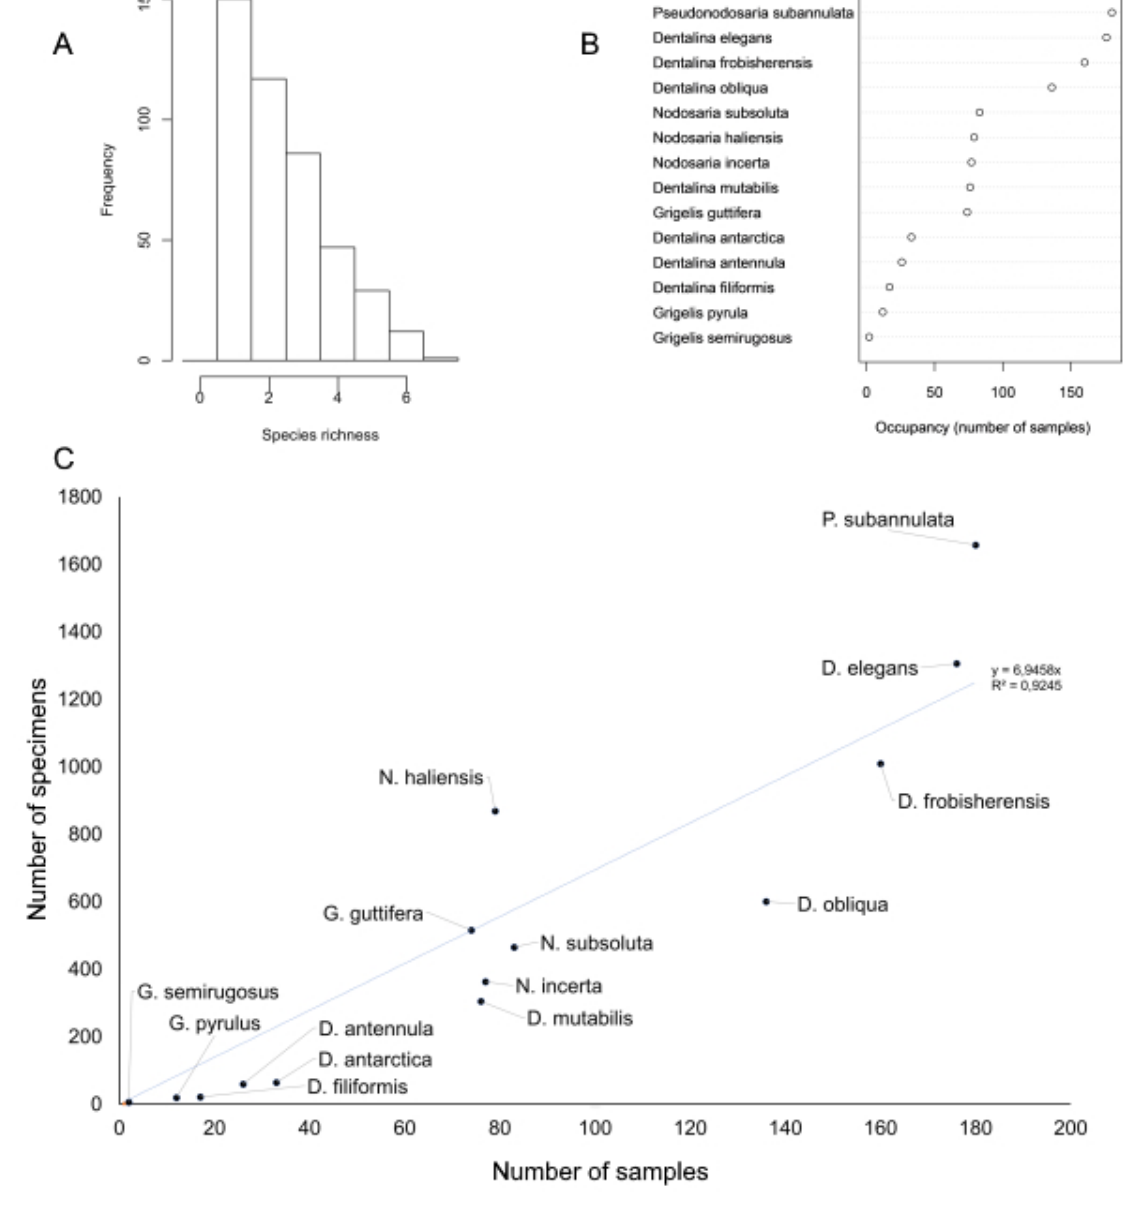
Fig. 17. Division of 7598 specimens among 14 species of Nodosariinae Ehrenberg, 1838, occurring in 447 BIOICE samples collected with RP- and detritus sledges. A . Number of samples ranked by number of species present. B . Number of samples occupied by each species. C . Relation between number of picked specimens of a species (y axis) and the number of samples it occupies (x